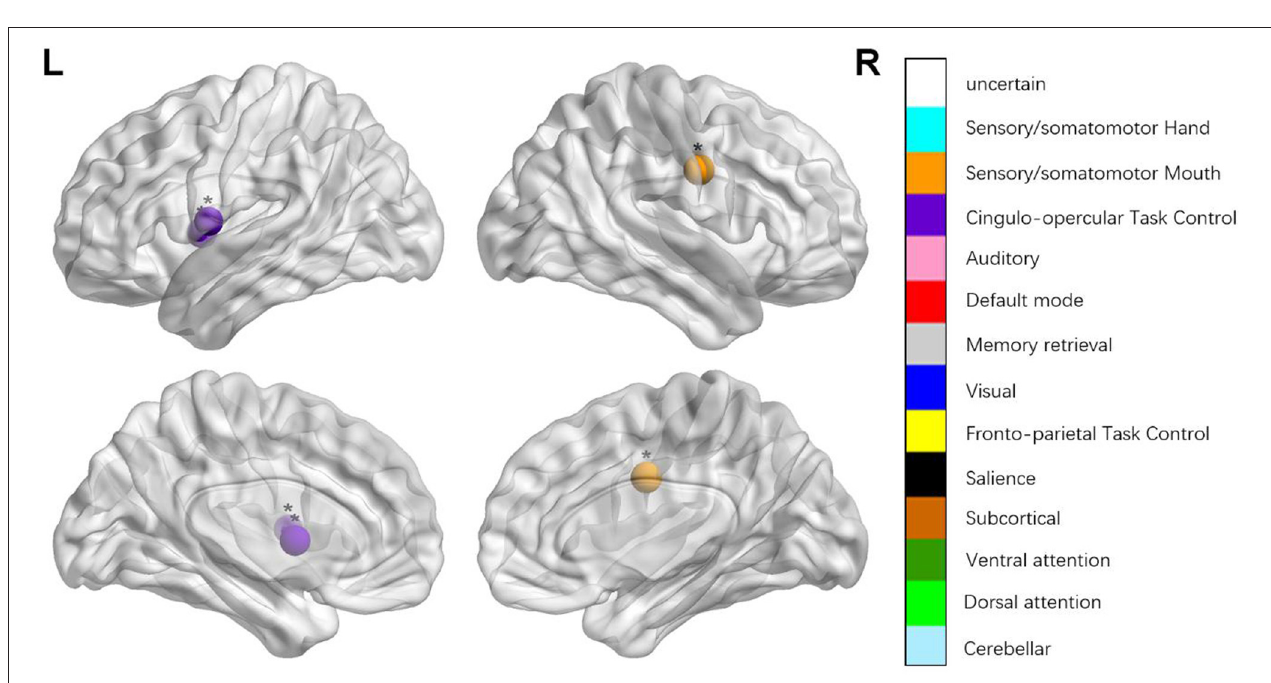
FIGURE 3 | Regions were considered abnormal nodal efficiency in patients with aphasia if they exhibited significant between-group differences. * p < 0.003787, Bonferroni correction (i.e., 1/264). ** p < 0.000189, Bonferroni correction (i.e., 0.05/264).